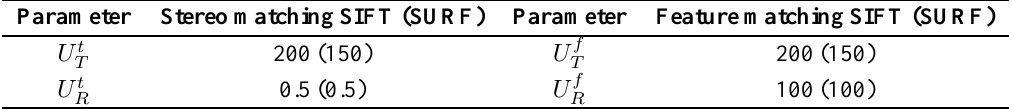
Table 1. Estimation of parameters for the visual odometry